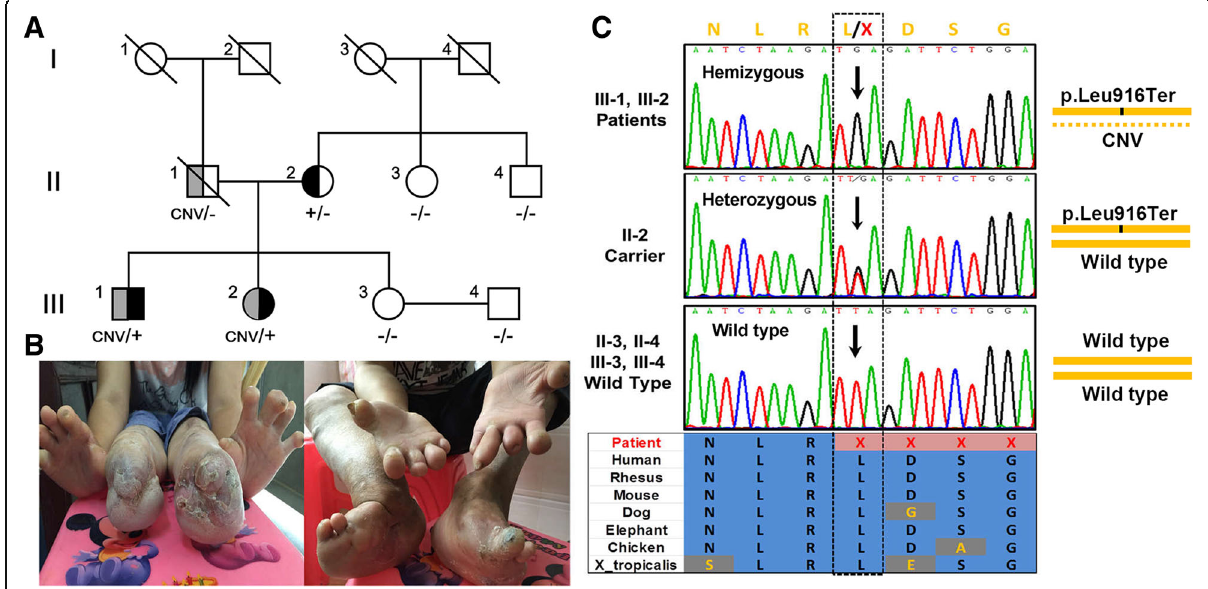
Fig. 1 Pedigree, clinical manifestation and molecular analysis of the family. a Pedigree of the family. Male and female are indicated by squares and circles, respectively. Full filled symbols represent HSAN affected individuals. Half full filled symbols represent WNK1 defect healthy carriers. Black symbols represent p.Leu916Ter carriers. Grey symbols represent CNV carriers. +/ − , represents heterozygous p.Leu916Ter carrier. CNV/ − , represents heterozygous CNV carrier. CNV/+, represents hemizygous p.Leu916Ter carrier. − / − , represents wild type. b Photos of two patients ’ “ burning feet and hands ” . c Confirmatory Sanger sequencing map of the p.Leu916Ter variant in WNK1 gene of the family and the